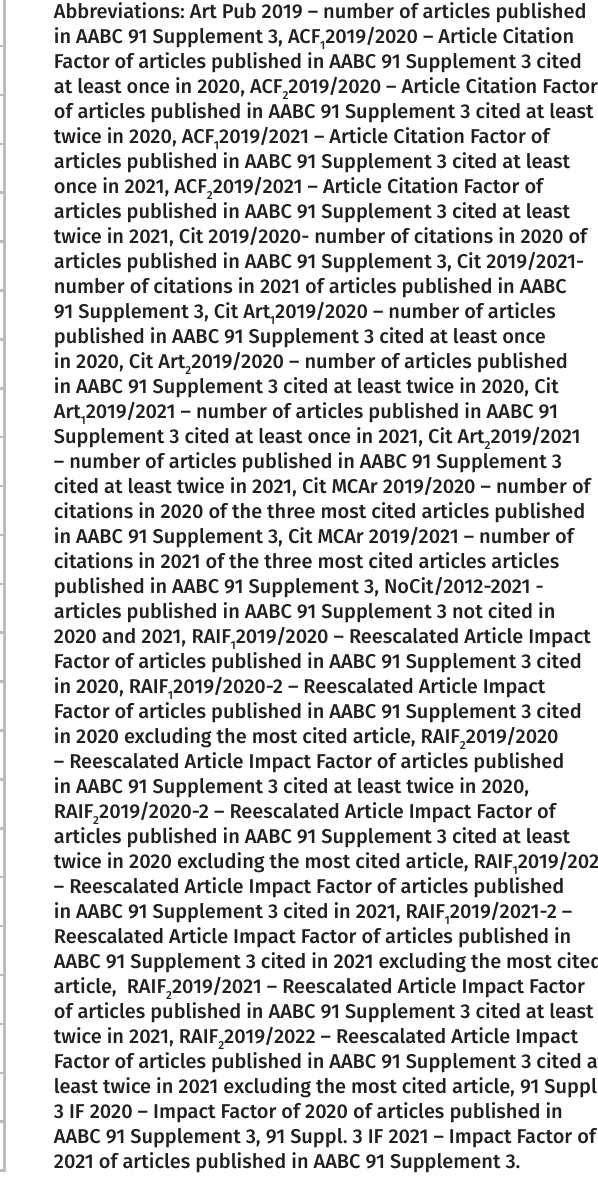
Table I. Citations and indexes concerning the articles on of the special issue 91 Supplement 3 of the Annals of the Brazilian Academy of Sciences considered in the Impact Factor of 2020 and